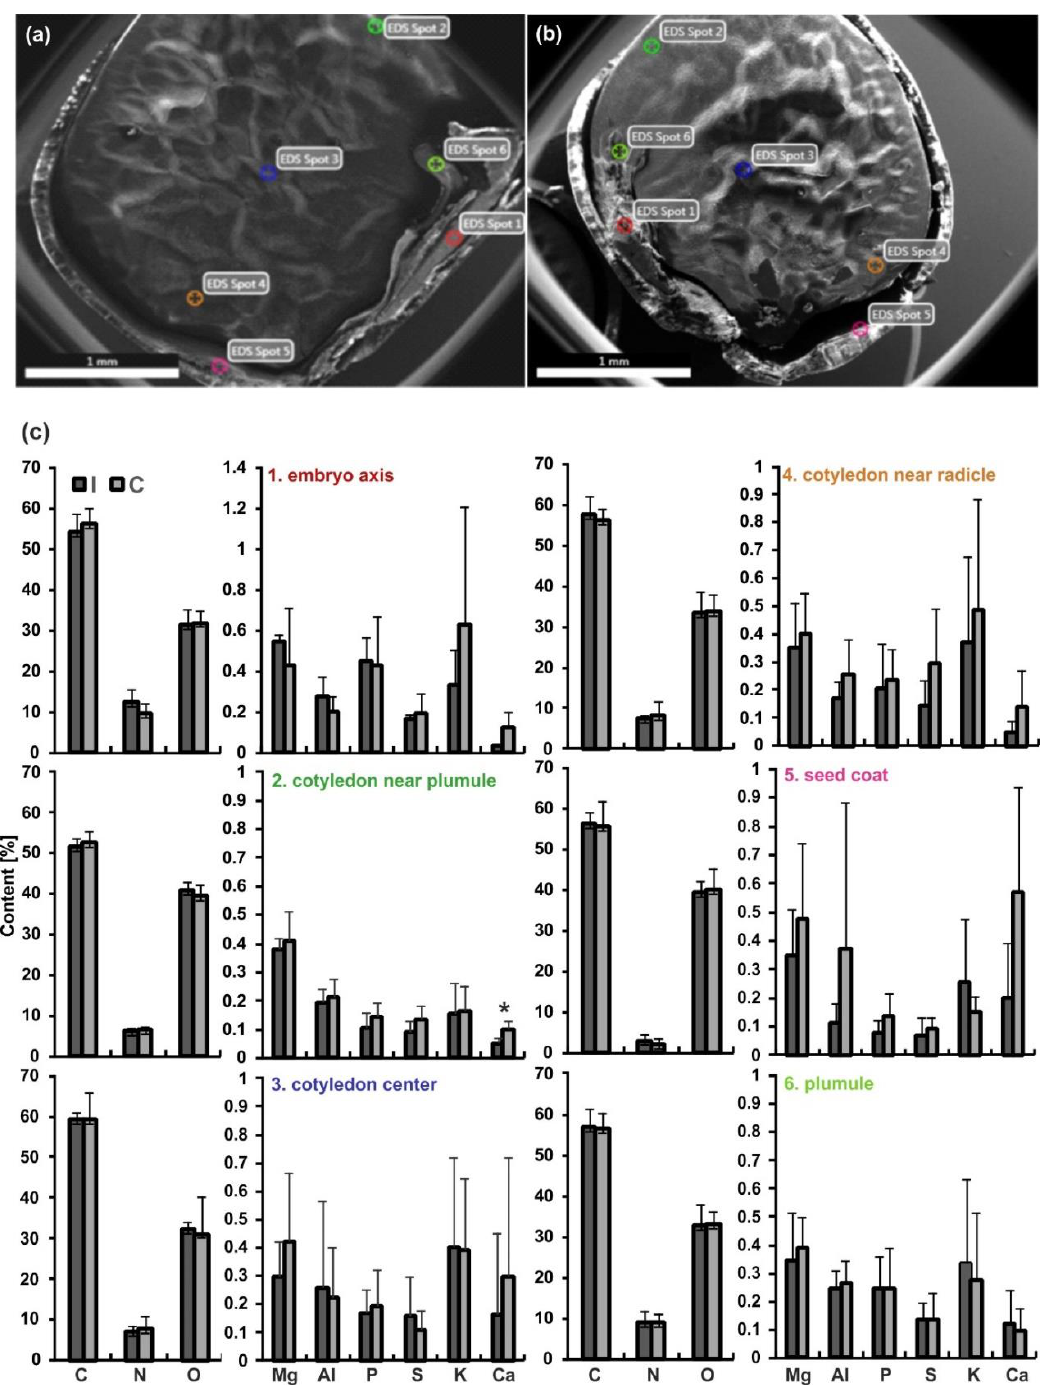
Figure 5. Scanning electron microscope (SEM) micrographs of yellow lupine half seeds: ( a ) Seed of a control plant. ( b ) Seed of an irrigated plant. The spots: 1-embryo axis, 2-cotyledon near plumule, 3-cotyledon center, 4-cotyledon near radicle, five-seed coat, six-plumule. ( c ) Corresponding content (weight %) of chemical elements (C, N, O, Mg, Al, P, S, K, Ca) in the indicated zones of seeds (C-control, I-irrigated plants, respectively). Statistical significance between mean values was assessed with the Student’s t-test ( p = 0.008). Error bars represent standard deviation (SD). An asterisk indicates statistically significant results.